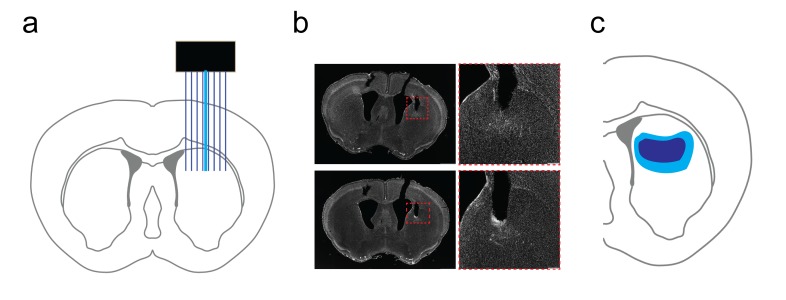
Verification of dorsal striatal in vivo recording array placement.(a) Cartoon schematic of multichannel array placement with optical fiber for light delivery in dorsal striatum. (b) Grayscale DAPI stained images of striatal slices (left) following in vivo recording with optogenetic stimulation. Scale bar, 1 mm. (Right) inset image of recording area in dashed red box on left. Scale bar, 200 µm. Note the track marking the dorsal boundary of the recording area. (c) Graphical representation of minimum (dark blue) and maximal (light blue) territories for in vivo array placement in dorsal striatum.